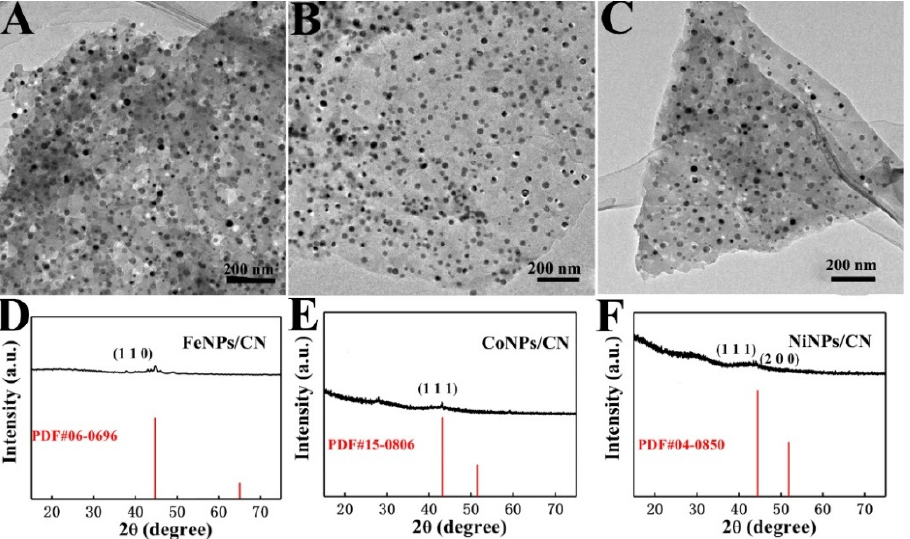
Figure 3. ( A ) TEM image of FeNPs/CN. ( B ) TEM image of CoNPs/CN. ( C ) TEM image of NiNPs/CN. ( D ) XRD pattern of FeNPs/CN. ( E ) XRD pattern of CoNPs/CN. ( F ) XRD pattern of NiNPs/CN.